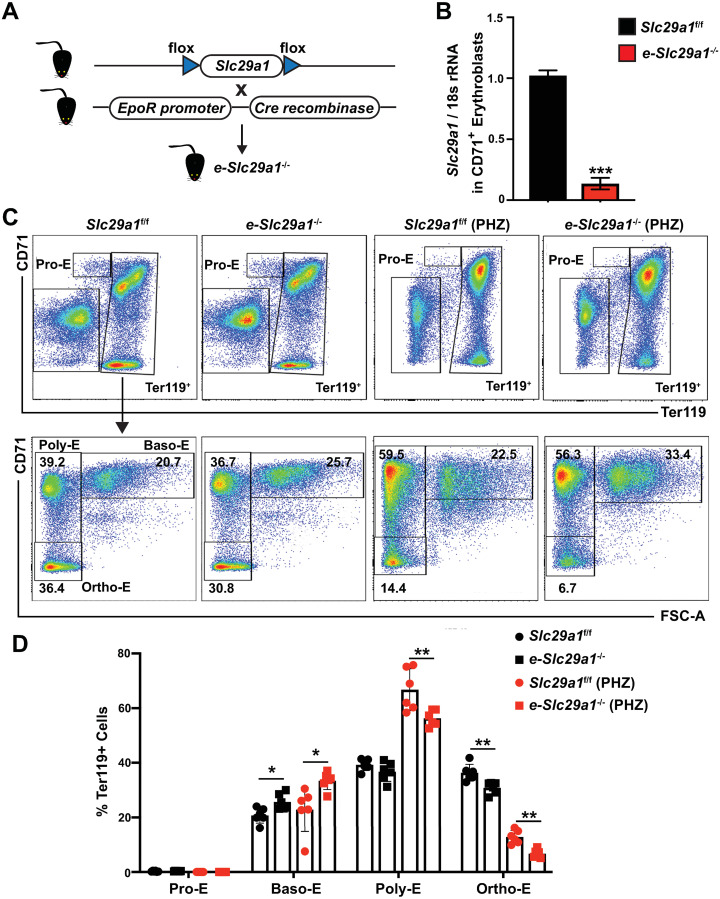
Targeted ablation of Slc29a1 in erythroblasts attenuates steady-state erythropoiesis and erythrocyte regeneration in bone marrow of an acute anemia mouse model.(A) Generation of e-Slc29a1-/- mice. (B) The relative expression of Slc29a1 in CD71+ cells from e-Slc29a1-/- and Slc29a1f/f mice was quantified by qRT-PCR (normalized to 18s rRNA). Students’ t test, ***p < 0.001. (C) Representative image of Pro-E, Baso-E, Poly-E, and Ortho-E. Top panel: Pro-erythroblasts (Pro-E) represent CD71highTer119- population; Lower panel: In gated Ter119+ erythroblasts, based on CD71 and Ter119 expression level, coupled with forward scatter (FSC), three stages of erythroid differentiation were defined: basophilic erythroblasts (Baso-E) were Ter119+CD71+ with a greater FSC; polychromatic erythroblasts (Poly-E) were Ter119+CD71+ with reduced FSC; and orthochromatic erythroblasts (Ortho-E) were Ter119+CD71-. (D) Frequencies of erythroblast populations. Each dot represents data obtained from one mouse. Data were analyzed with a two-way ANOVA, followed by a Tukey’s multiple comparisons test, *p < 0.05, **p < 0.01.